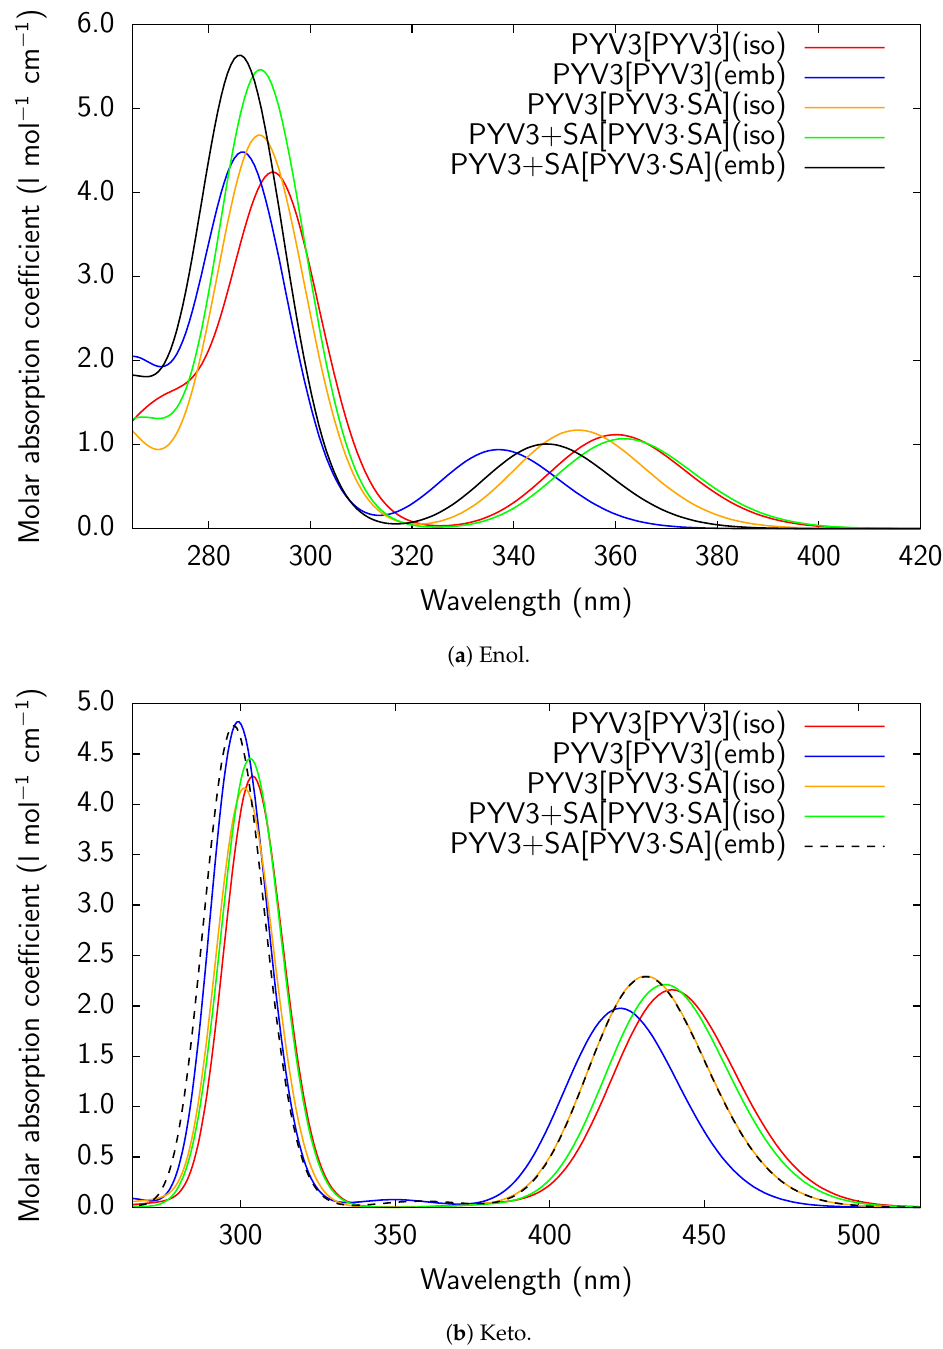
Figure 5. RI-CC2/def2-TZVPD UV/Vis absorption spectra of all models considered for PYV3 and PYV3 ·